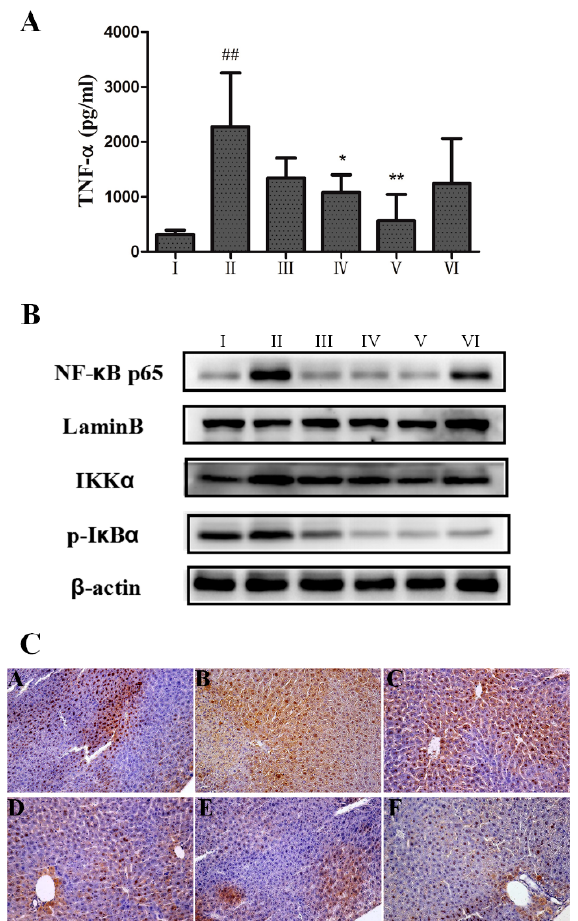
Figure 5. Anti-inflammatory effect of AEOV on liver tissues. ( A ) Serum tumor necrosis factor (TNF) α level. Groups are as follows. І : saline; ІІ : saline + CCl 4 ; ІІІ : AEOV 125 mg/kg + CCl 4 ; І V: AEOV